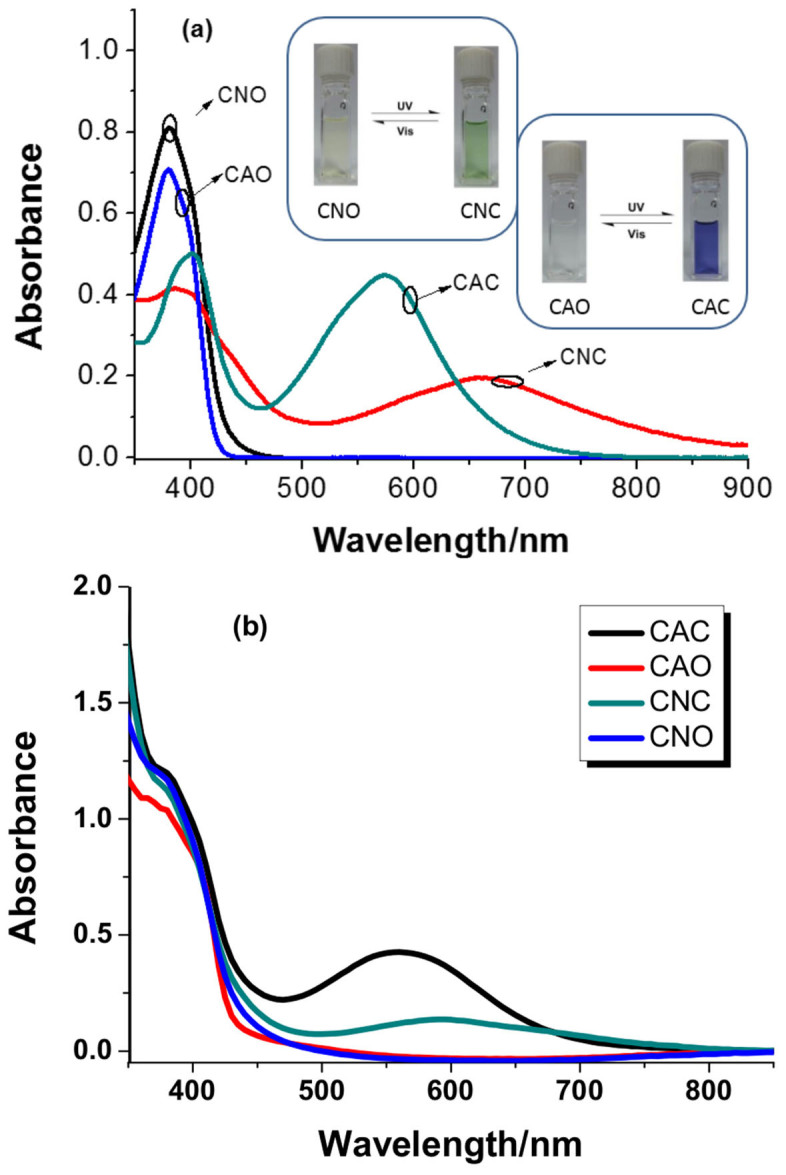
(a) UV-Vis absorption spectra of different photoisomers. Inset: Photographic images of interconversion between CAO and CAC or CNO and CNC under the alternative irradiation with UV or visible light in CH2Cl2 solution. (b) The absorption spectra of CAO, CAC, CNO and CNC on TiO2 film.